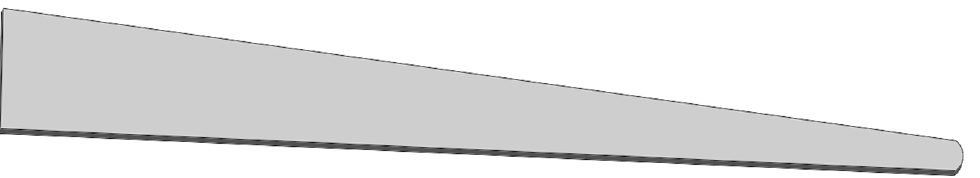
Figure 1. CAD design of a horizontal axis turbine blade.